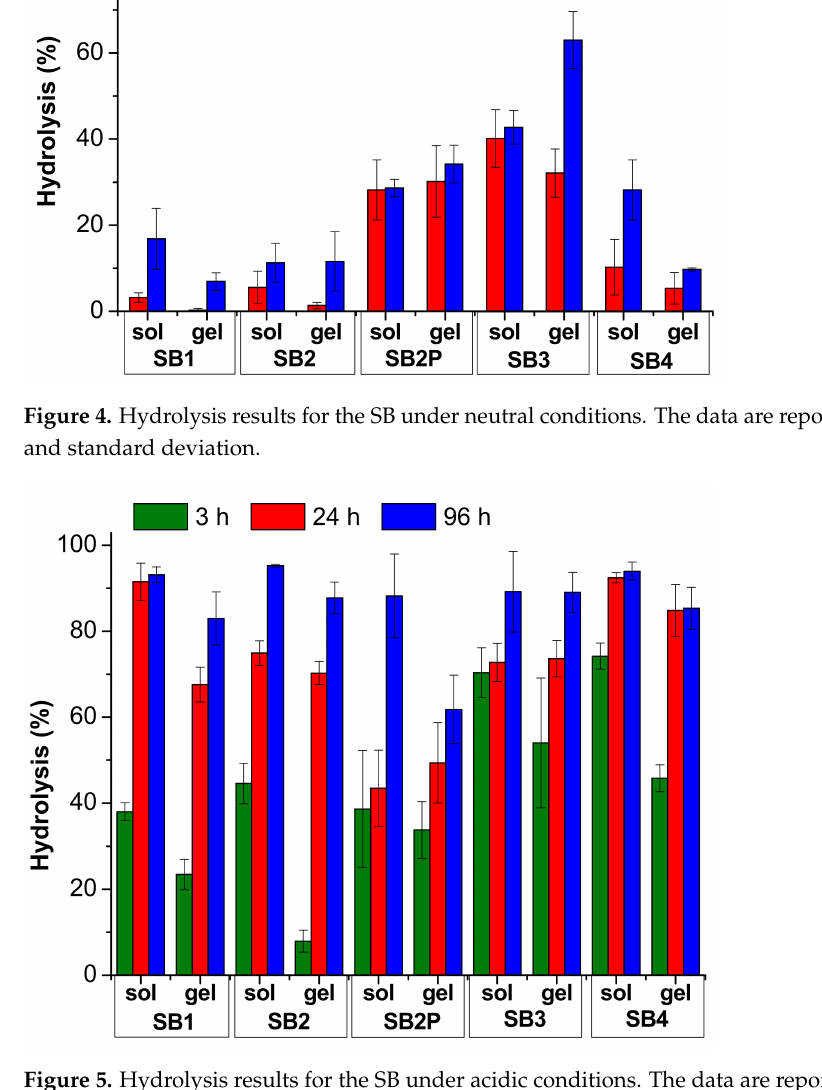
Figure 5. Hydrolysis results for the SB under acidic conditions. The data are reported as mean value and standard